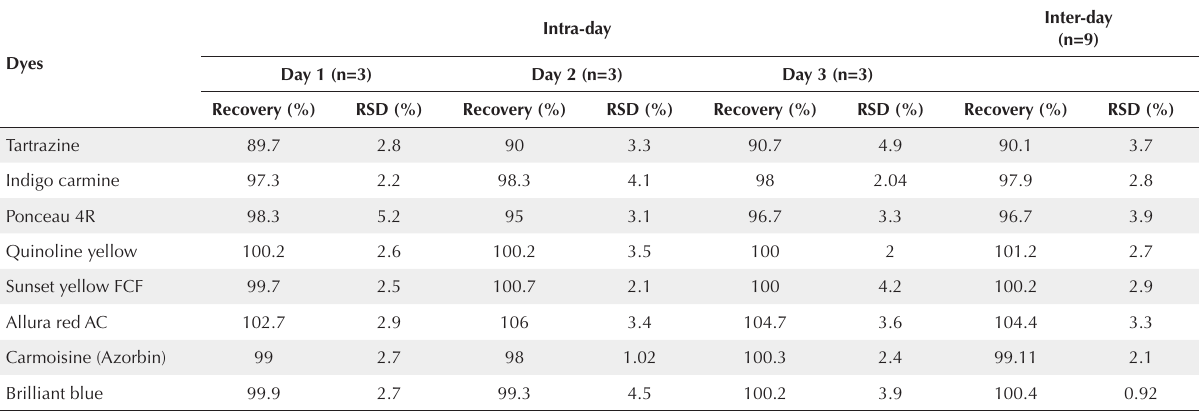
Table 6. Intra and inter-day accuracy (recovery %) and precision (rsd %) for mixture of 8 synthetic dyes extracted by SPE from 10 mL of water containing 2 µg of each dye standard